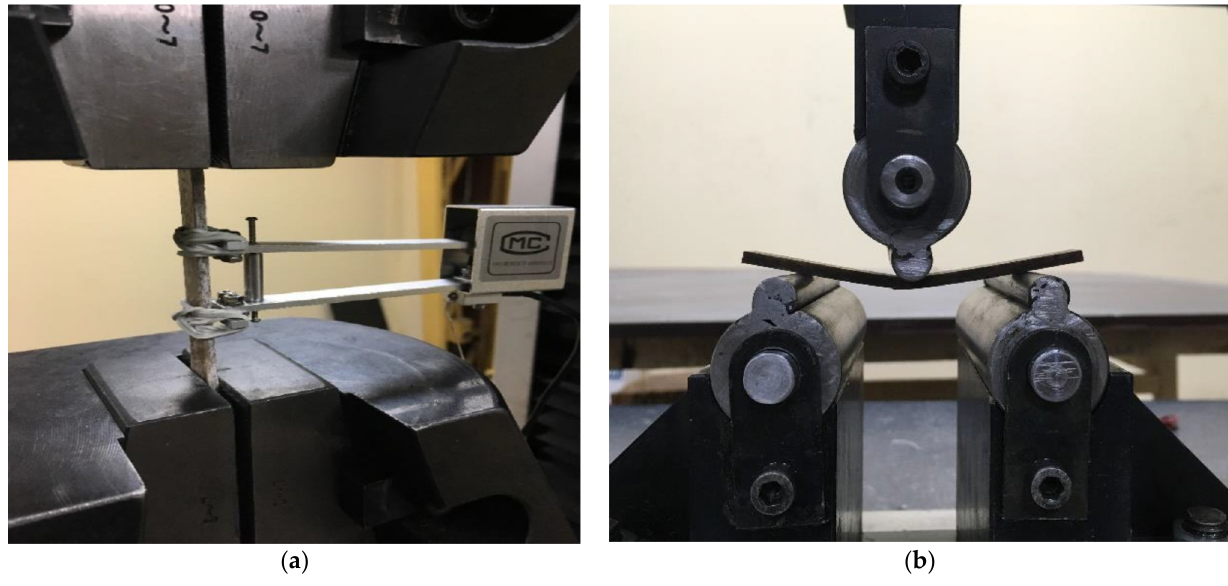
Figure 1. Experimental tests: ( a ) tensile test and ( b ) fl exural test.